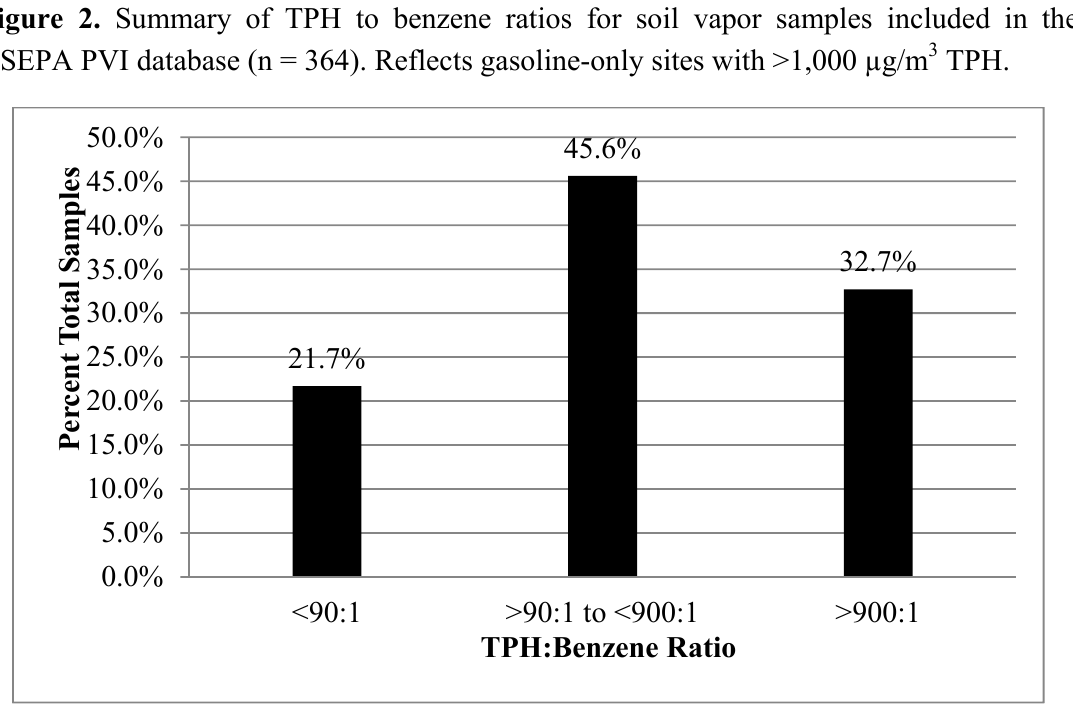
Figure 2. Summary of TPH to benzene ratios for soil vapor samples included in